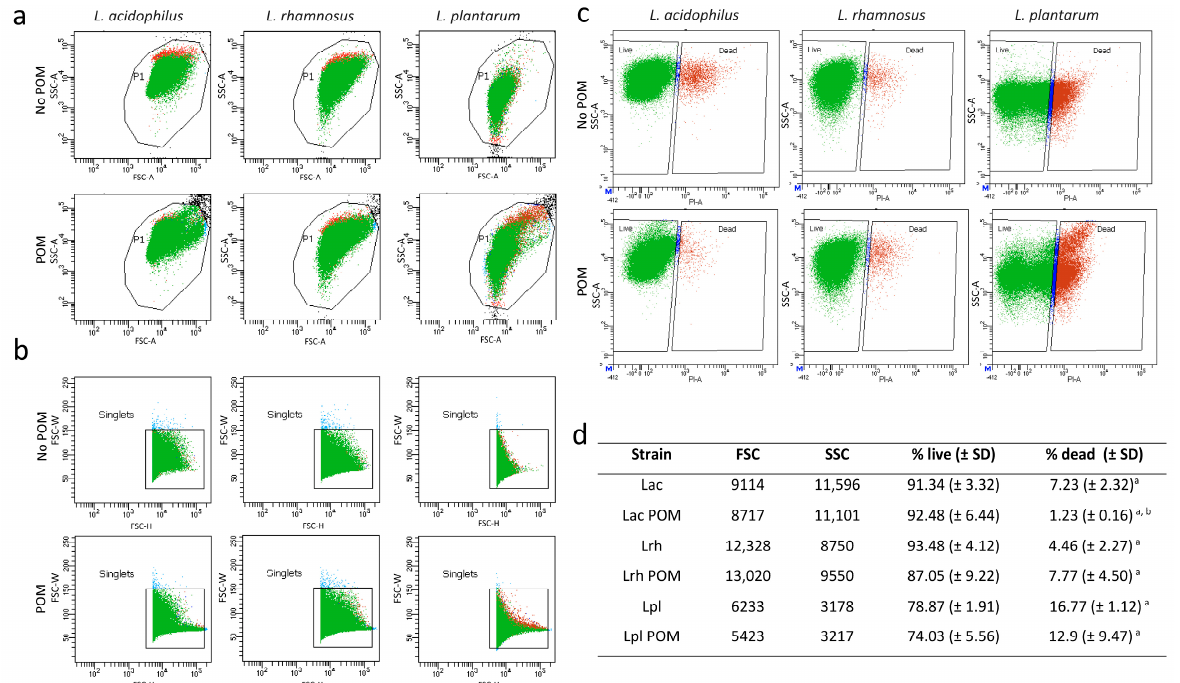
Figure 2. Flow cytometry analysis of probiotic strains grown in the presence of POM extract. Side ( a ) and forward ( b ) plots for each of the three strains. LIVE/DEAD staining with propidium iodide ( c , d ). Representative plots with corresponding forward scatter (FSC) and side scatter (SSC) values are shown. In panel ( d ), superscript a denotes a p value of ≤ 0.05 when comparing % live and % dead cells, and superscript b denotes a p value ≤ 0.05 when comparing % live or % dead values for each strain after growth in POM versus the control with no POM.